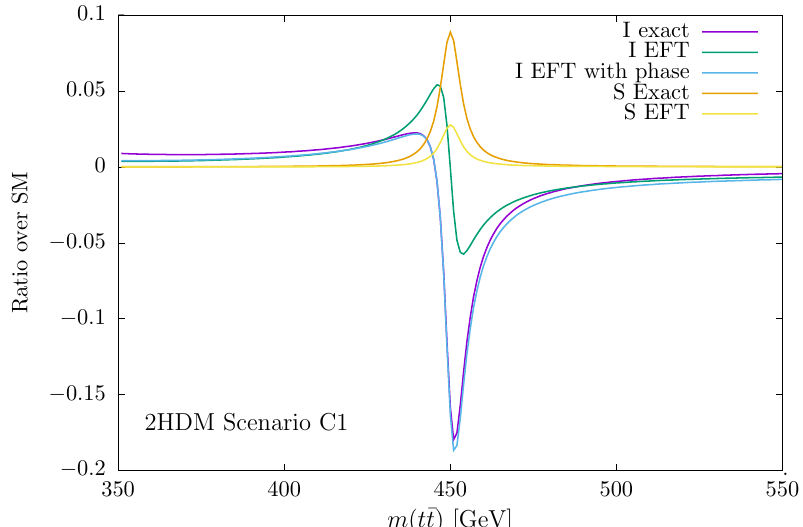
Figure 9 . Signal (S) and interference (I) over background ratios, computed from EFT (with and without the additional phase) and from the exact one-loop